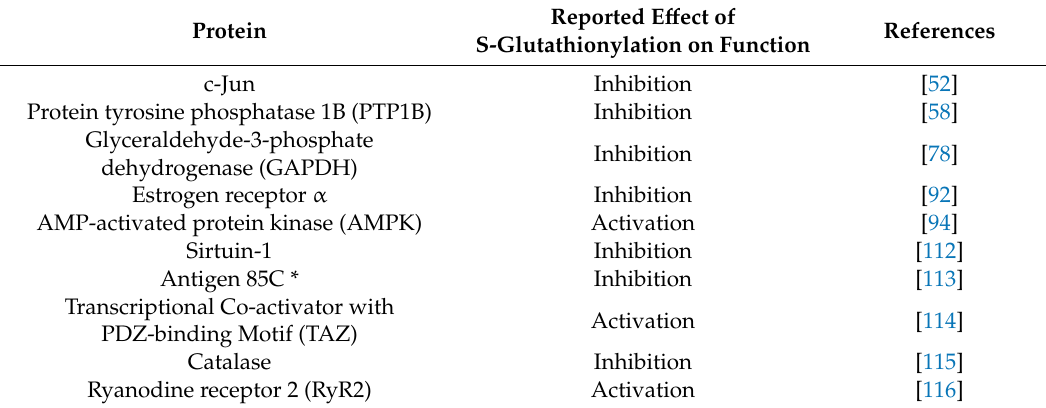
Table 1. Examples of the e ff ect of S-glutathionylation on protein